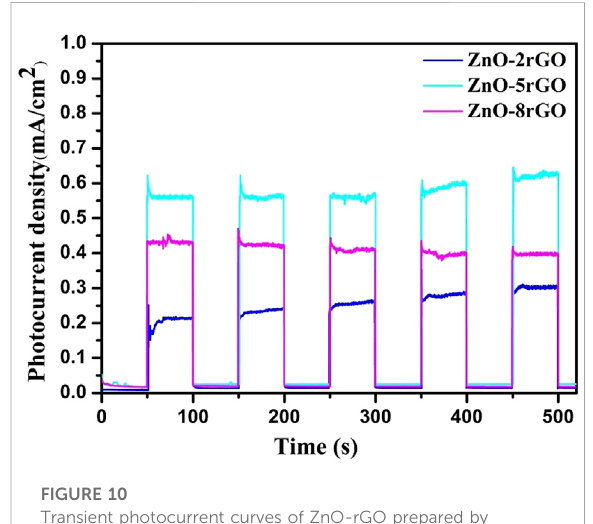
FIGURE 10 Transient photocurrent curves of ZnO-rGO prepared by different concentrations of